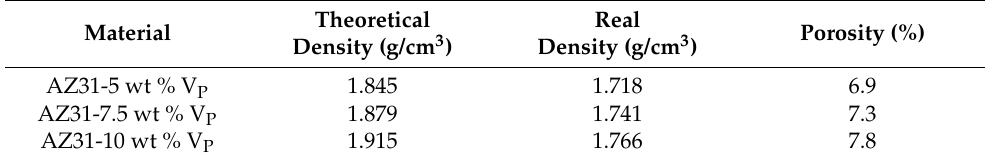
Table 1. Theoretical, real density and porosity of sintered AZ31–V P composites.